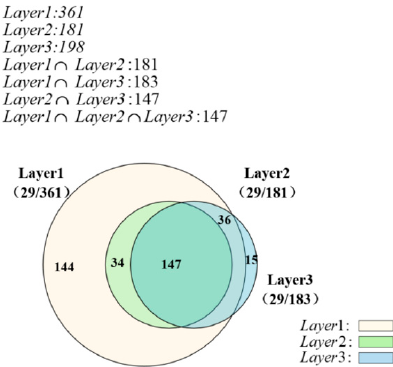
Figure 14. Distribution of overlapping edges in the three original layers.